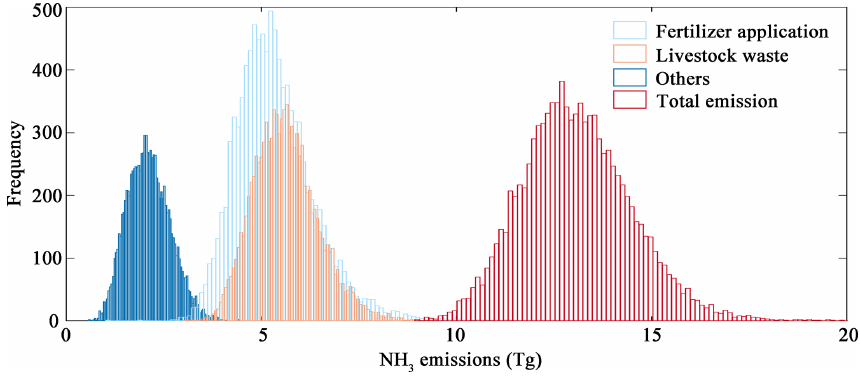
Figure 6. Uncertainties in NH 3 emissions sourced from fertilizer application, livestock waste, and others.